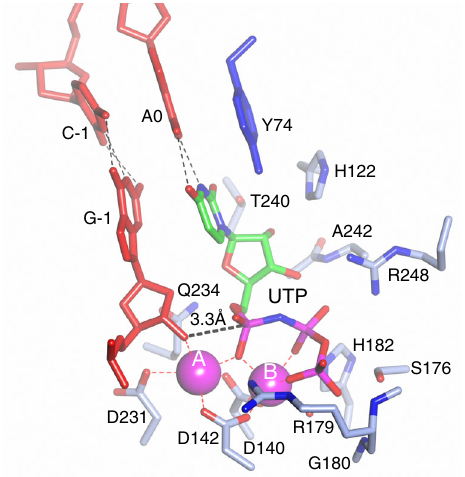
Fig. 2 Active-site geometry of the Prim – PolC – DNA ternary complex. Molecular details of the docking of the 3 ′ -terminal nucleotide of the incoming primer strand as the enzyme positions the 3 ′ -OH moiety to attack the α -phosphate of the bound non-hydrolysable UTP analogue, UpNHpp. Hydrogen bonds are depicted in black, and dative bonding of the catalytic manganese ions (magenta spheres) is depicted in red. R179 appears to act as a gating side chain and is evidently in a closed